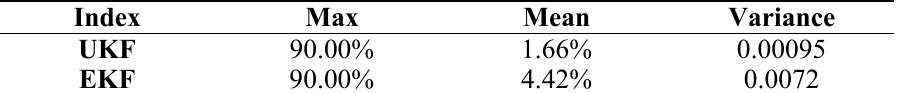
Table 3. Comparison of SoC